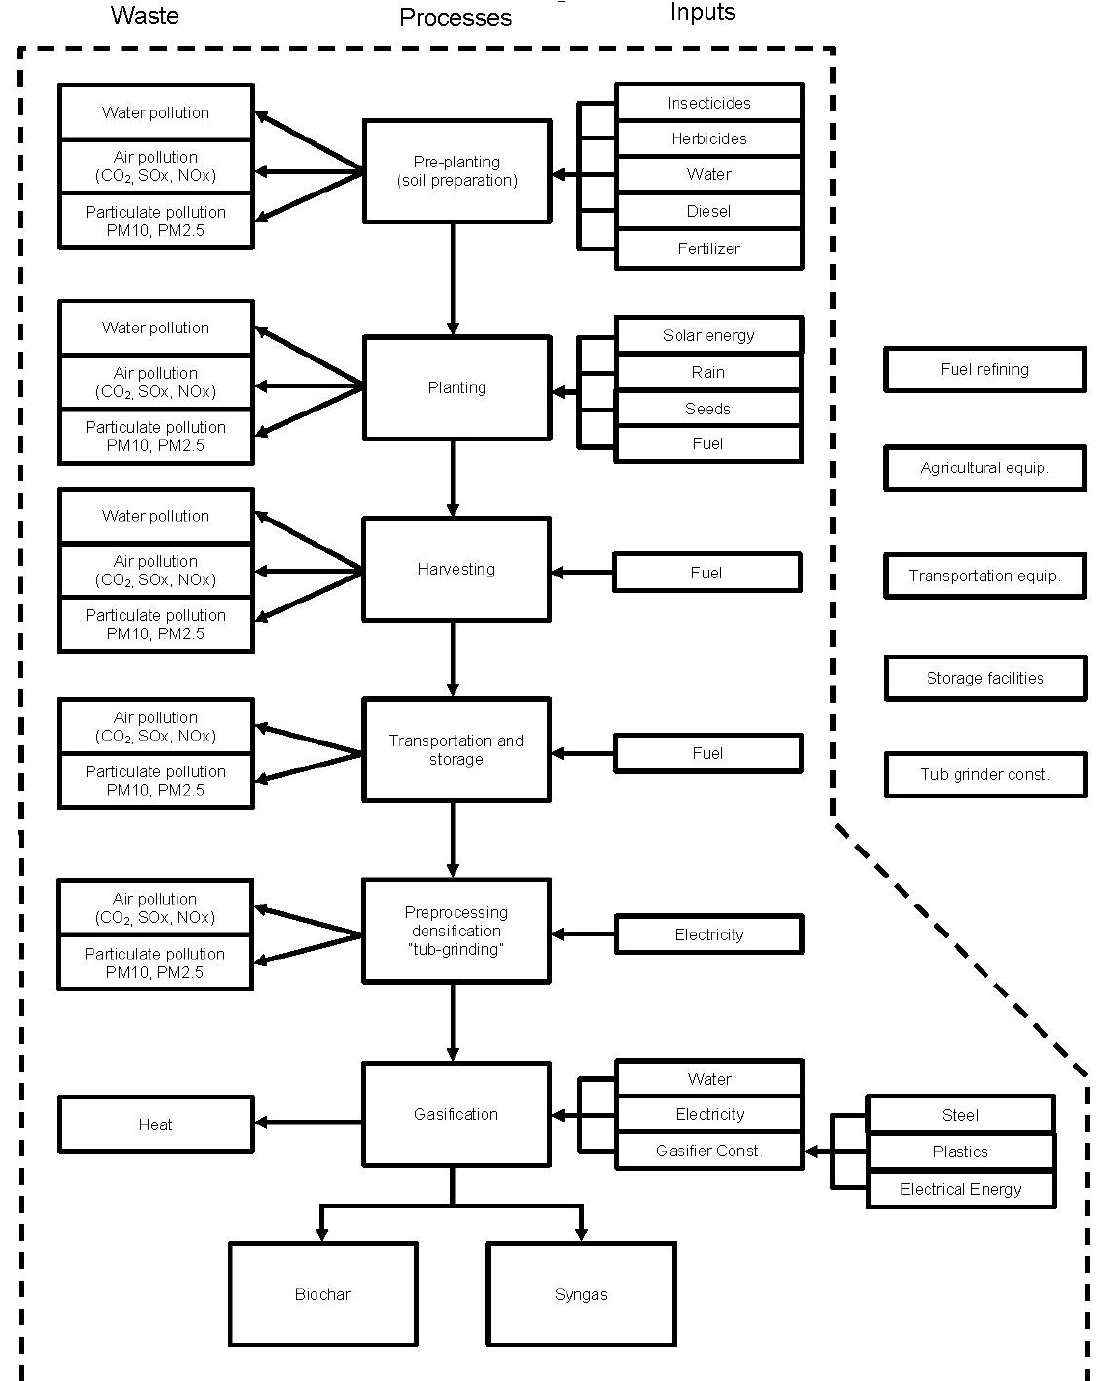
Figure 2. Simplified system boundaries (inside dotted line) for biochar